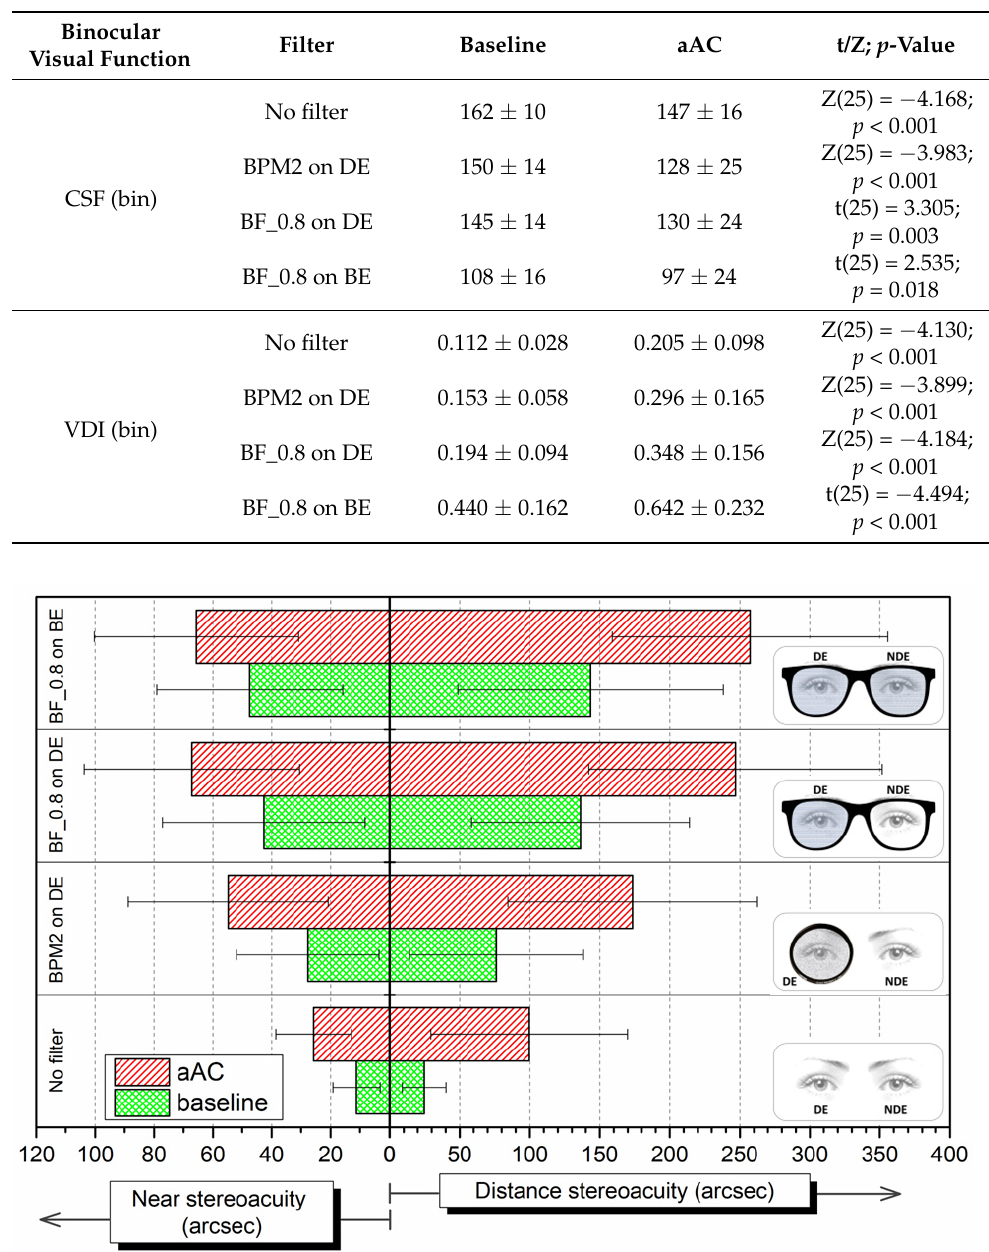
Figure 1. Bar graph of mean stereoacuity (near and distance) values in baseline and after alcohol consumption (aAC) for the different filter conditions: no filter; BMP2 fog filter on the dominant eye (BMP2 on DE); Bangerter foil of 0.8 on the dominant eye (BF_0.8 on DE); and Bangerter foil of 0.8 on both eyes (BF_0.8 on BE). Standard deviations included. NDE: non dominant eye.